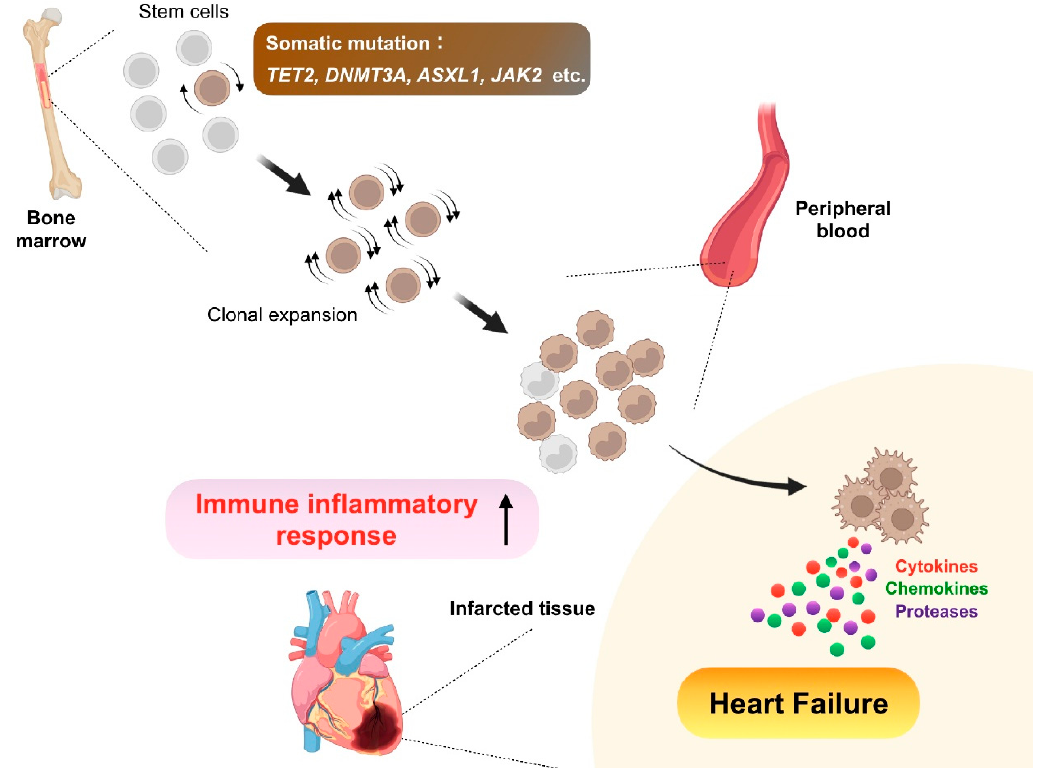
Figure 3. Clonal hematopoiesis. As we age, somatic mutations accumulate in bone marrow hematopoietic stem cells, some of which confer a competitive advantage or fitness, leading to clonal expansion of the mutated cells. Consequently, the bone marrow expels clonal descendants of the mutant stem cells into peripheral circulation. In this premalignant condition called clonal hematopoiesis, genes frequently mutated are Tet methylcytosine dioxygenase 2 (TET2), DNA methyltransferase 3 alpha (DNMT3A), addition of sex combs like 1 (ASXL1), and Janus kinase 2 (JAK2), and the somatic mutations confer both increased proliferation capacity and inflammatory signature to the mutated cells, thereby leading to adverse post-infarction heart failure with enhanced inflammation.